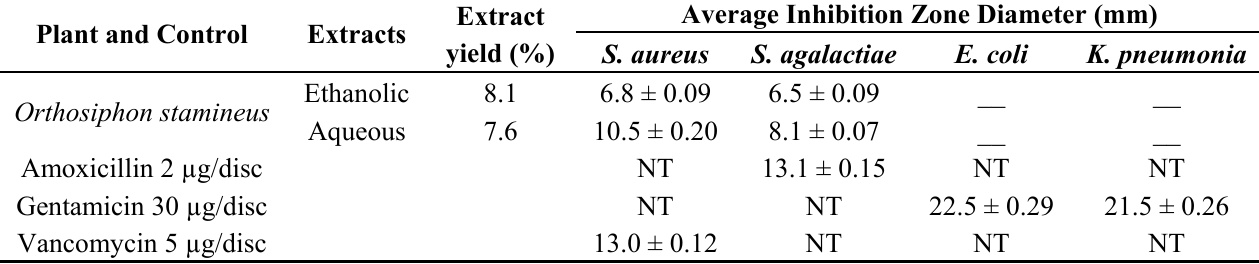
Table 1. Antimicrobial activity of O. stamineus in disk diffusion